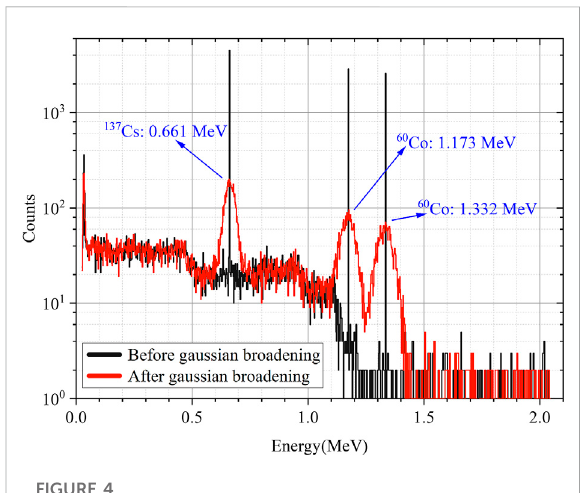
FIGURE 4 Gamma spectra before and after Gaussian broadening.